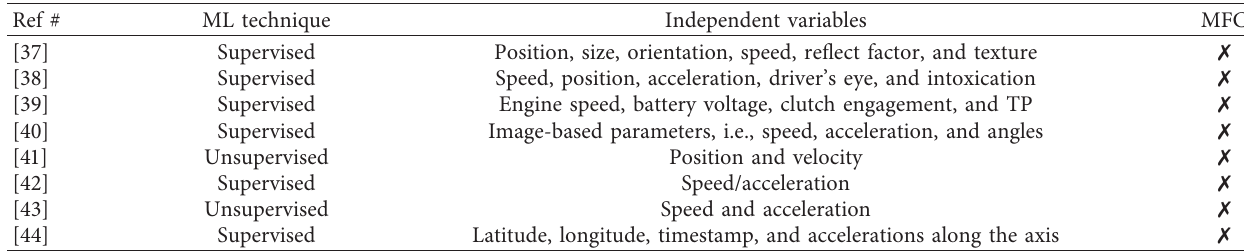
Table 3: Summary of reckless driving detection systems.